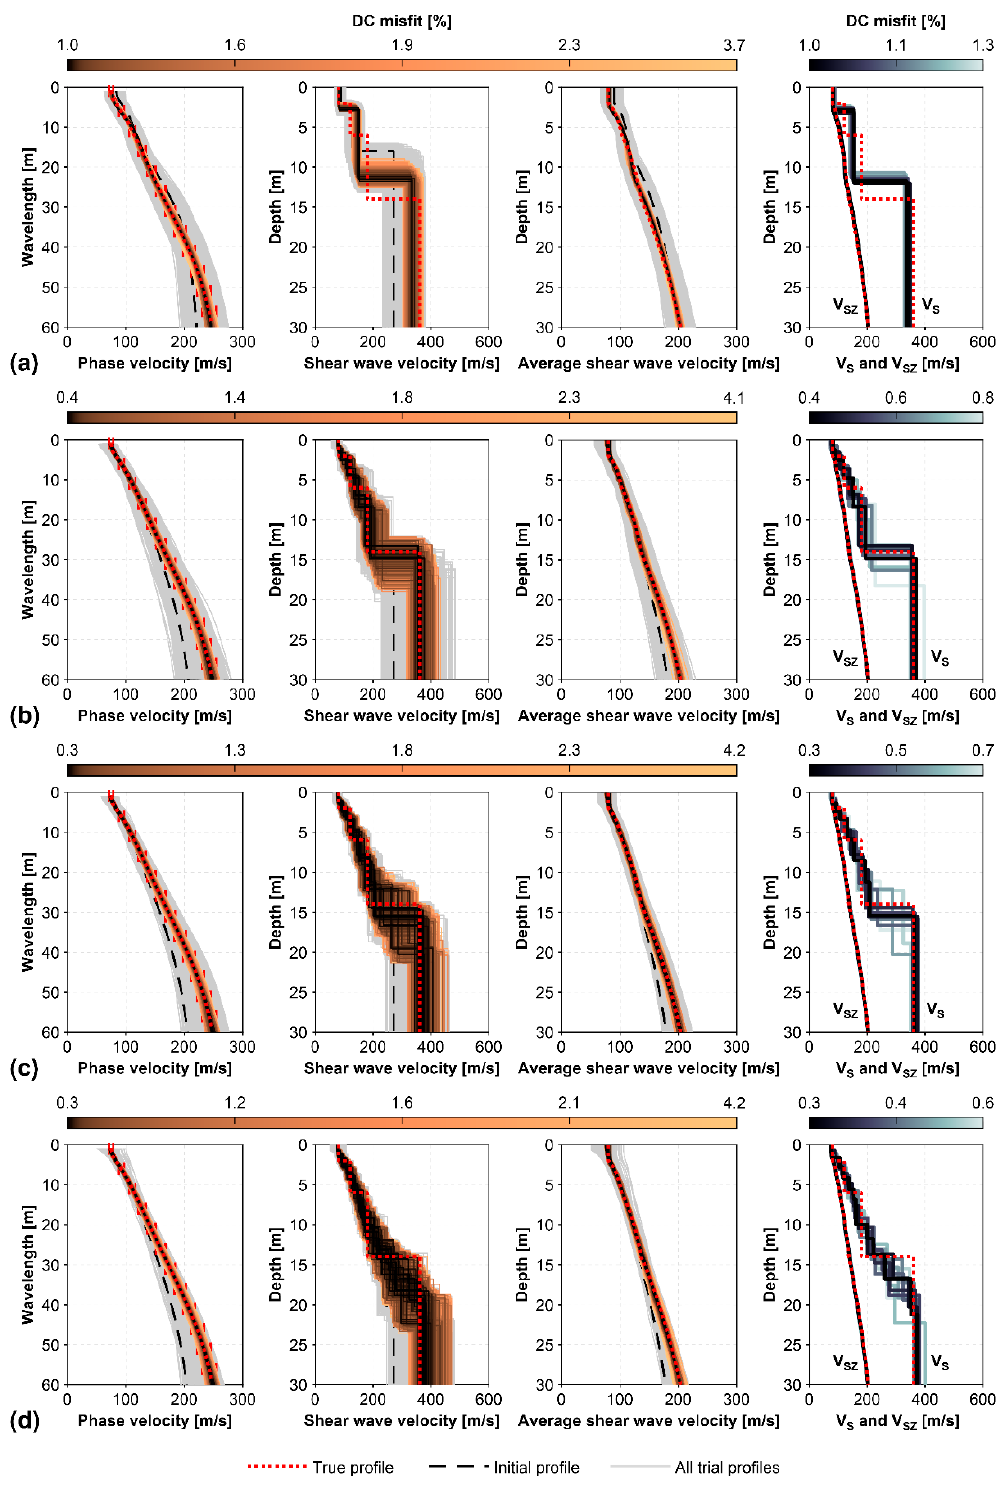
Figure 13. Inversion of the unperturbed synthetic dispersion curve from model B. A geologic structure consisting of ( a ) three, ( b ) six, ( c ) eight and ( d ) twelve layers (including the half-space) was assumed.